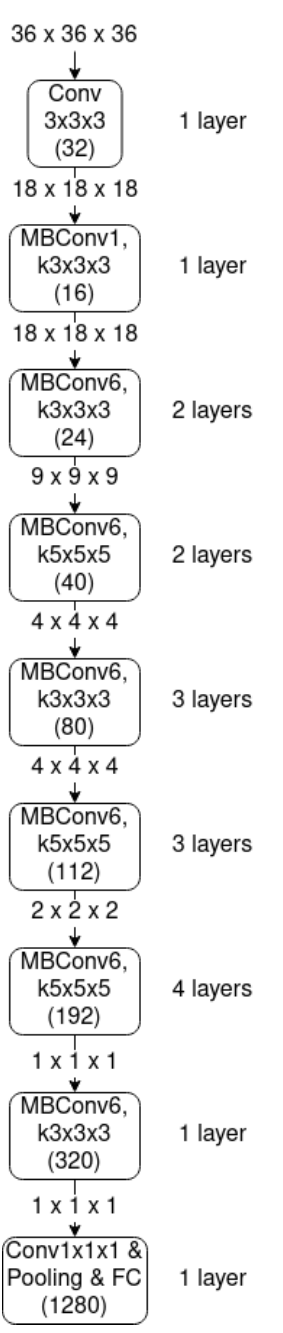
Figure 9. EfficientNet base architecture